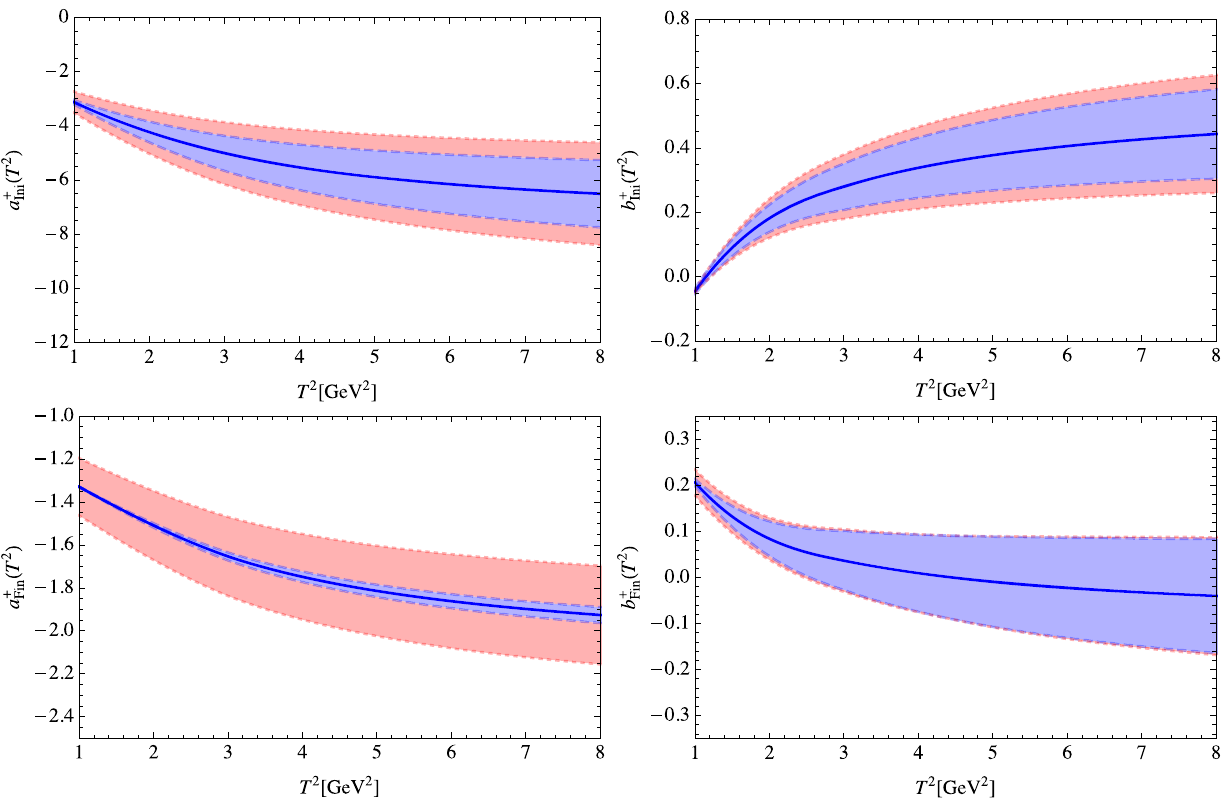
Fig. 3 Decay amplitudes a + J and b + J (in unit 10 − 3 GeV 2 ) as functions of the Borel parameter T 2 . In each diagram, the blue band denotes the error from the uncertainty of the threshold s th = 2 . 85 2 ± 0 . 5 GeV 2 . The upper and lower red bands denote the error from the uncertainty of λ